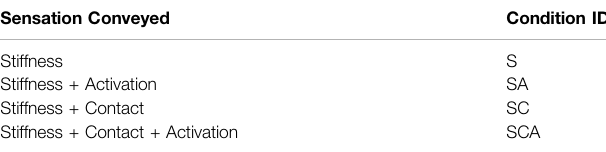
TABLE 2 | Conditions and sensations conveyed for experiment